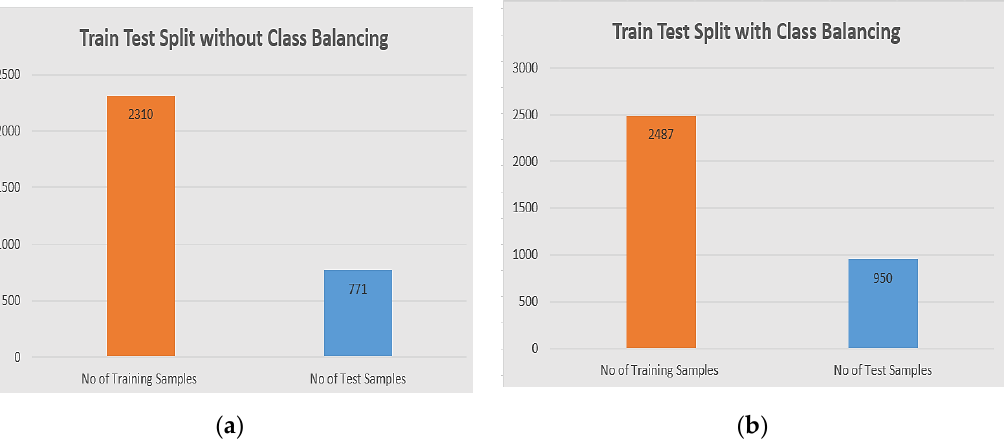
Figure 7. The division of train/test validation: ( a ) the distribution of training samples are 2310 in the training set, and 771 in the test set original dataset before class balancing; ( b ) the distribution of training samples is 2387, and the test is 950 after class balancing.